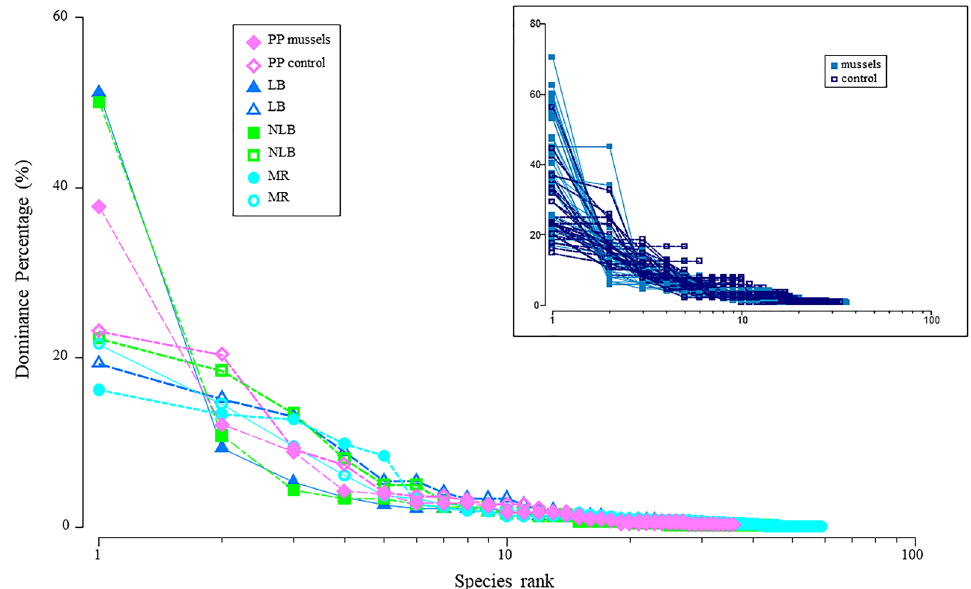
Figure 4. Ranked species abundance plot for pooled macrofauna cores (n = 8), split by site (colour) and mussel bed status (fill). Inset: dominance curves for all macrofauna cores (n = 64), split by mussel beds (light blue, filled) and soft-sediment controls (dark blue, open), highlighting increased dominance percentage in mussel bed communities. Labels for y-axis (relative abundance as a percentage of total abundance observed) and x-axis (species rank on log scale) are the same for both